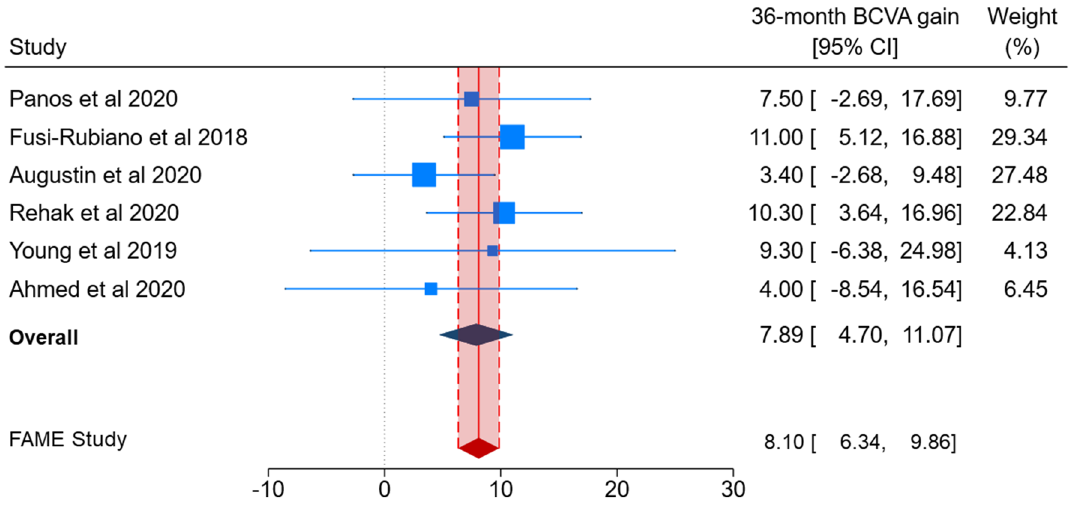
Figure 3. A forest plot showing 36-month best corrected visual acuity (BCVA) gain, reported as Mean Difference (MD) with 95% confidence interval (CI), in real-world studies and 36-month BCVA gain in the FAME